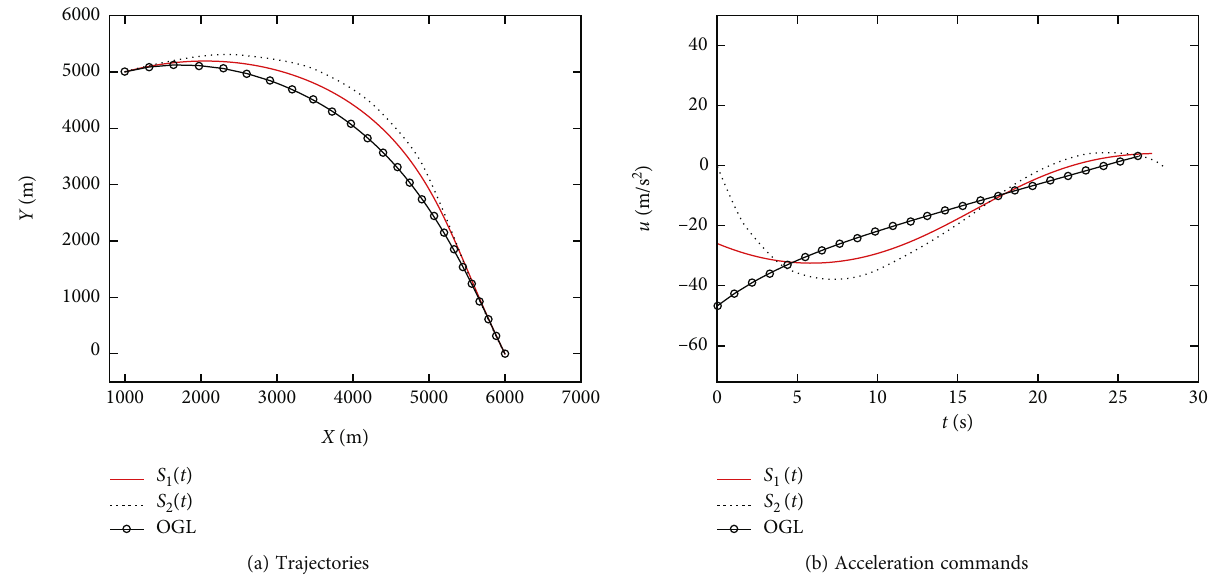
Figure 5: The comparison results of di ff erent weighting functions for γ